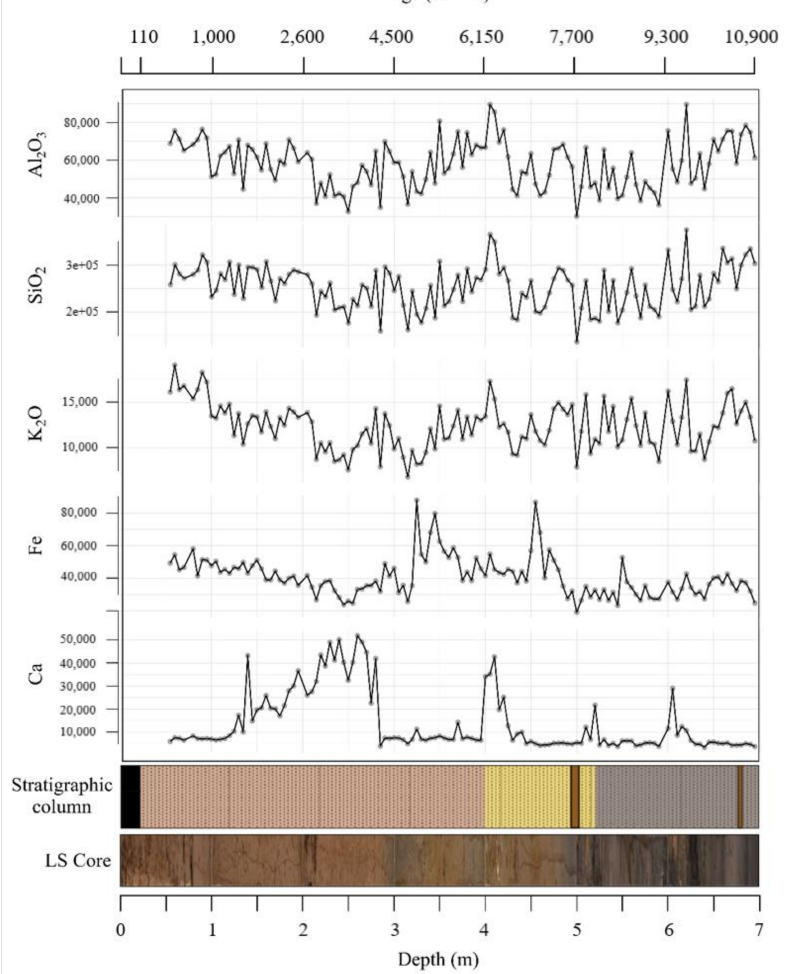
Figure 6. Geochemical proxies’ distribution against depth (m) and age (cal BP), with the strati- graphic column and LS core presented at the bottom. Concentration of each element is presented in counts